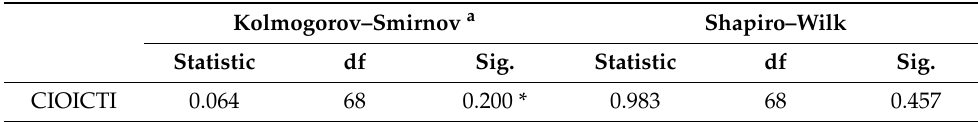
Table 12. Tests of Normality.